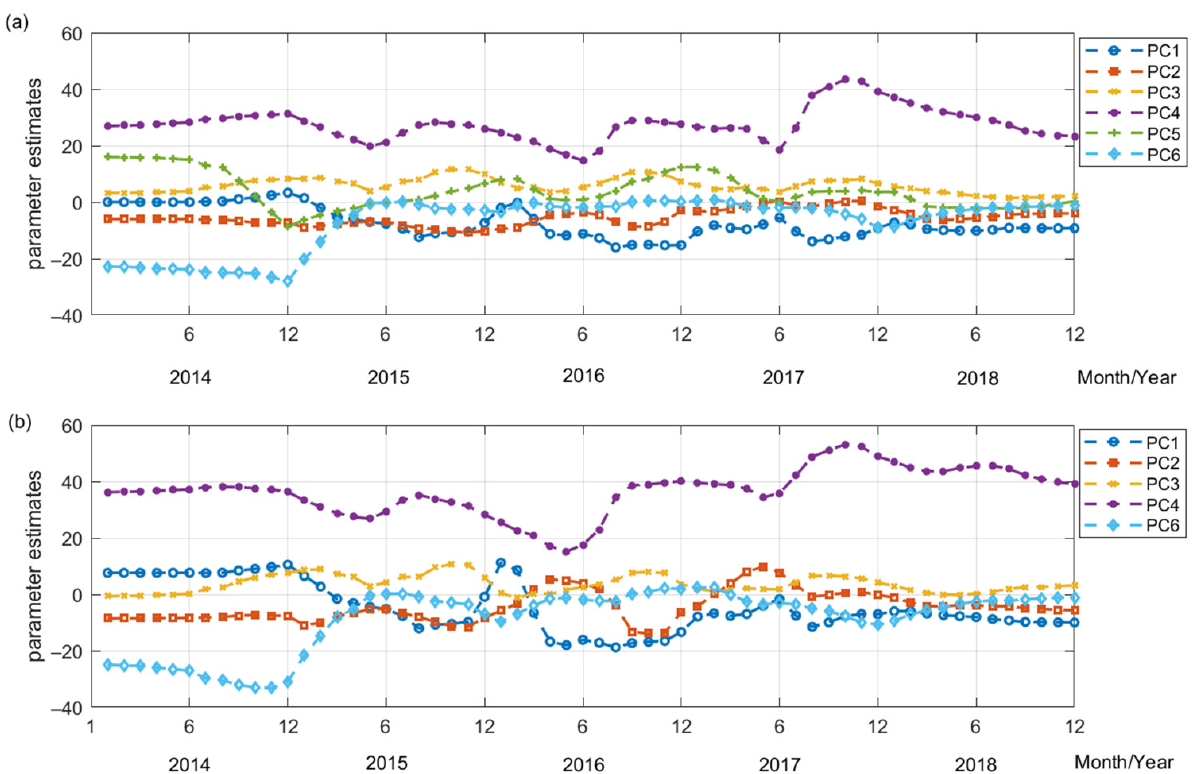
Figure 4. The temporal changes of PCA-GTWR parameter estimates for PM from 2014 to 2018: ( a ) PM 2.5 ; ( b ) PM 10 . Note: PC1—temperature; PC2—wind speed; PC3—pressure; PC4—atmospheric pollutant; PC5—humidity; PC6—vegetation coverage.